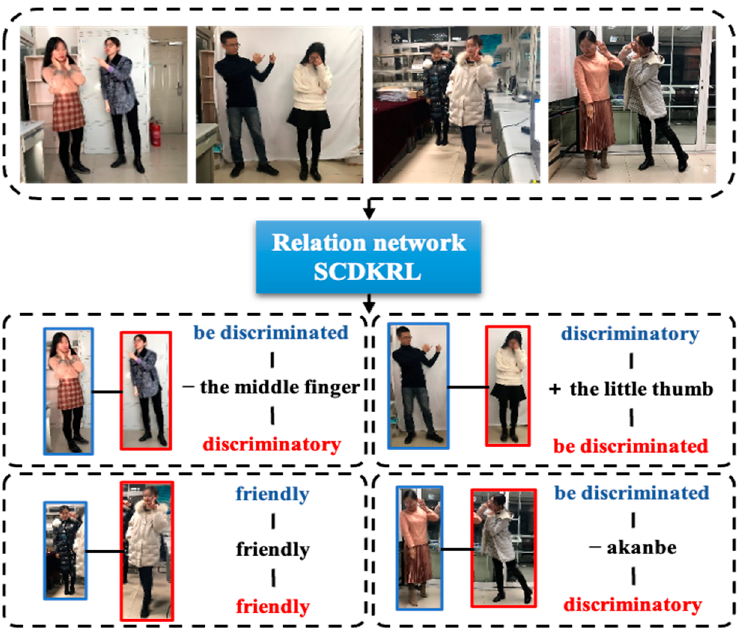
Figure 1. With a discriminatory or friendly image as input, the model outputs the action category of persons in the image and the relationship category of the persons. - indicates be discriminated, + of persons in the image and the relationship category of the persons. − indicates be discriminated, indicates discriminatory. + indicates